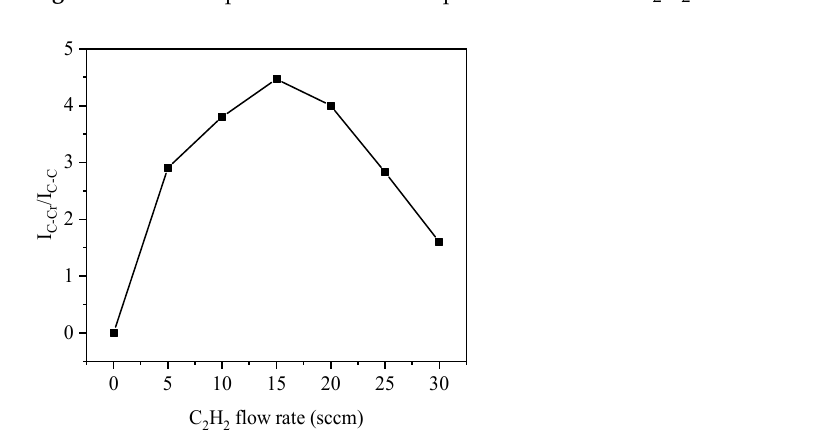
Figure 3. C1s XPS spectra of CrC films deposited at different C 2 H 2 flow rates.